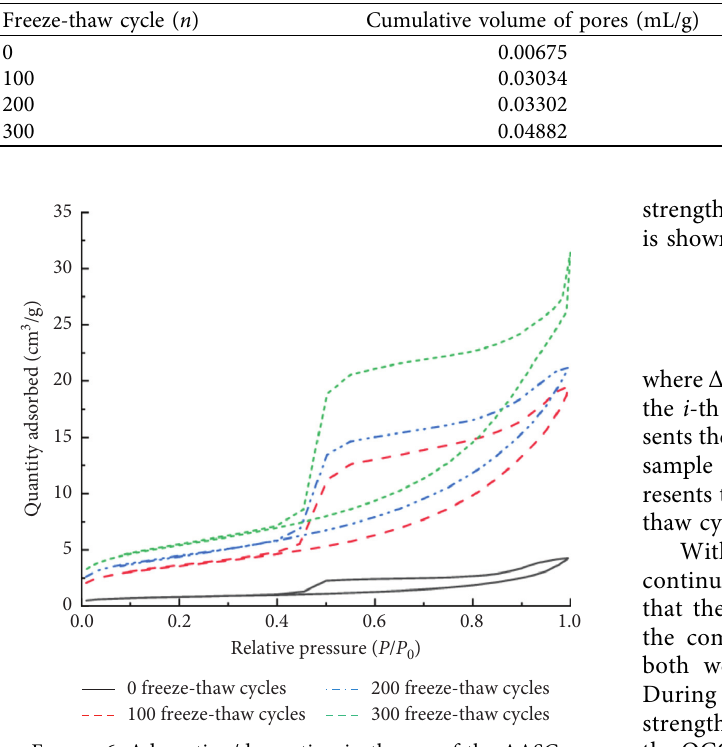
Table 4: Pore structure parameter after the freeze-thaw cycle.